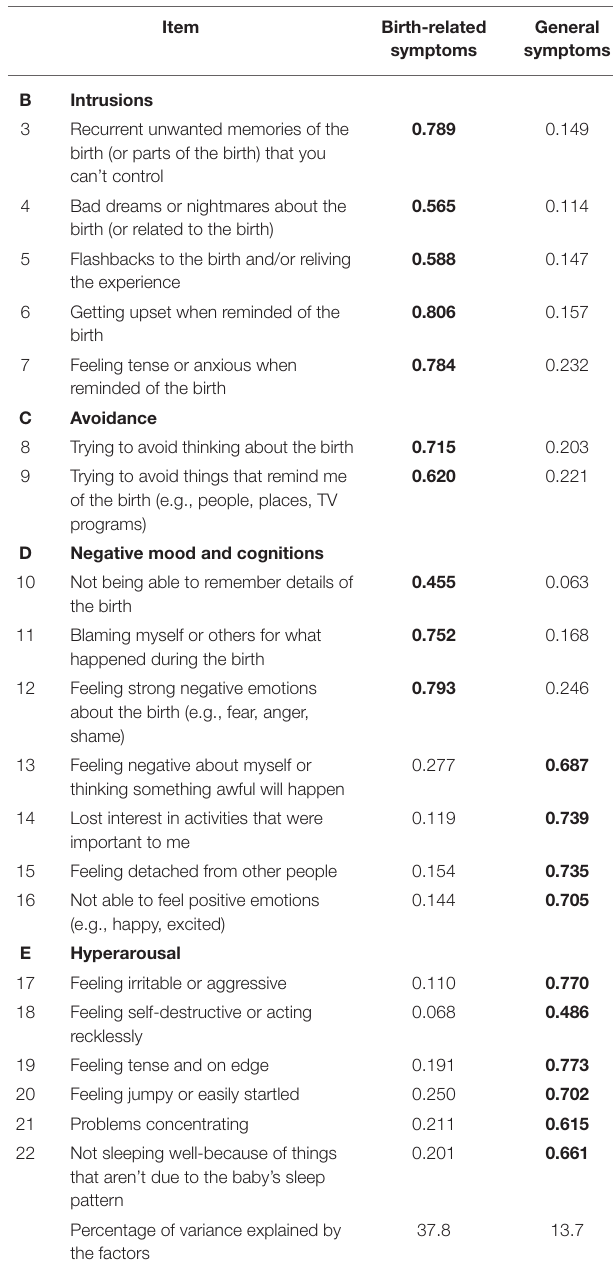
TABLE 3 | Factor loadings of the EFA with two factors in principal component analysis with varimax